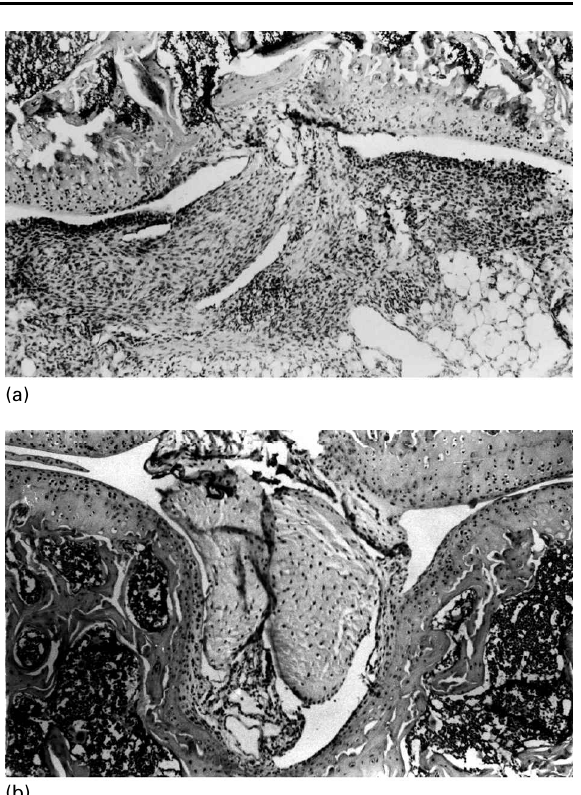
FIG. 1. (a) Histological section of the knee joint infected with 15mg/ml of zymosan. Extensive pannus formation with erosion of joint cartilage and bone. Hematoxylin and eosin, 100 ´ . (b) Mouse treated with zymosan plus Spirulina, 400mg/kg p.o. Histology of the knee shows only minimal inflammatory reaction. Hematoxylin and eosin, 100 ´